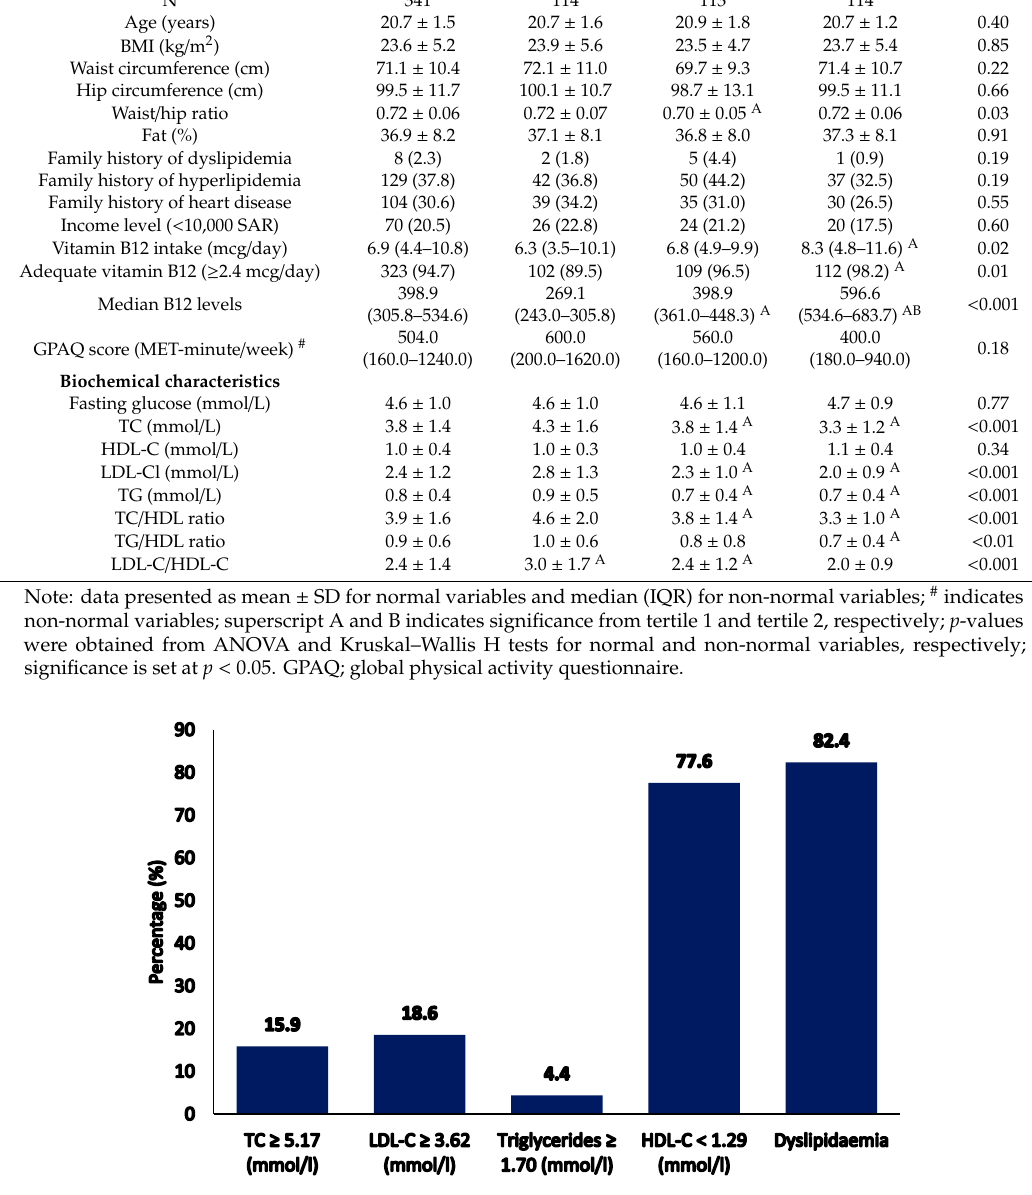
(Table 2). One SD increase in serum vitamin B12 levels (176.5 pmol / L) reduced TC, TG, and LDL-C by 0.38, 0.07, and 0.34 pmol / L, respectively (Table 2). Multiple logistic regression found that serum vitamin B12 level was inversely related to dyslipidemia but was not significant when adjusted for all confounders. The results were similar when BMI was replaced by either height and WHR, height and fat percentage, or height and central obesity (Table